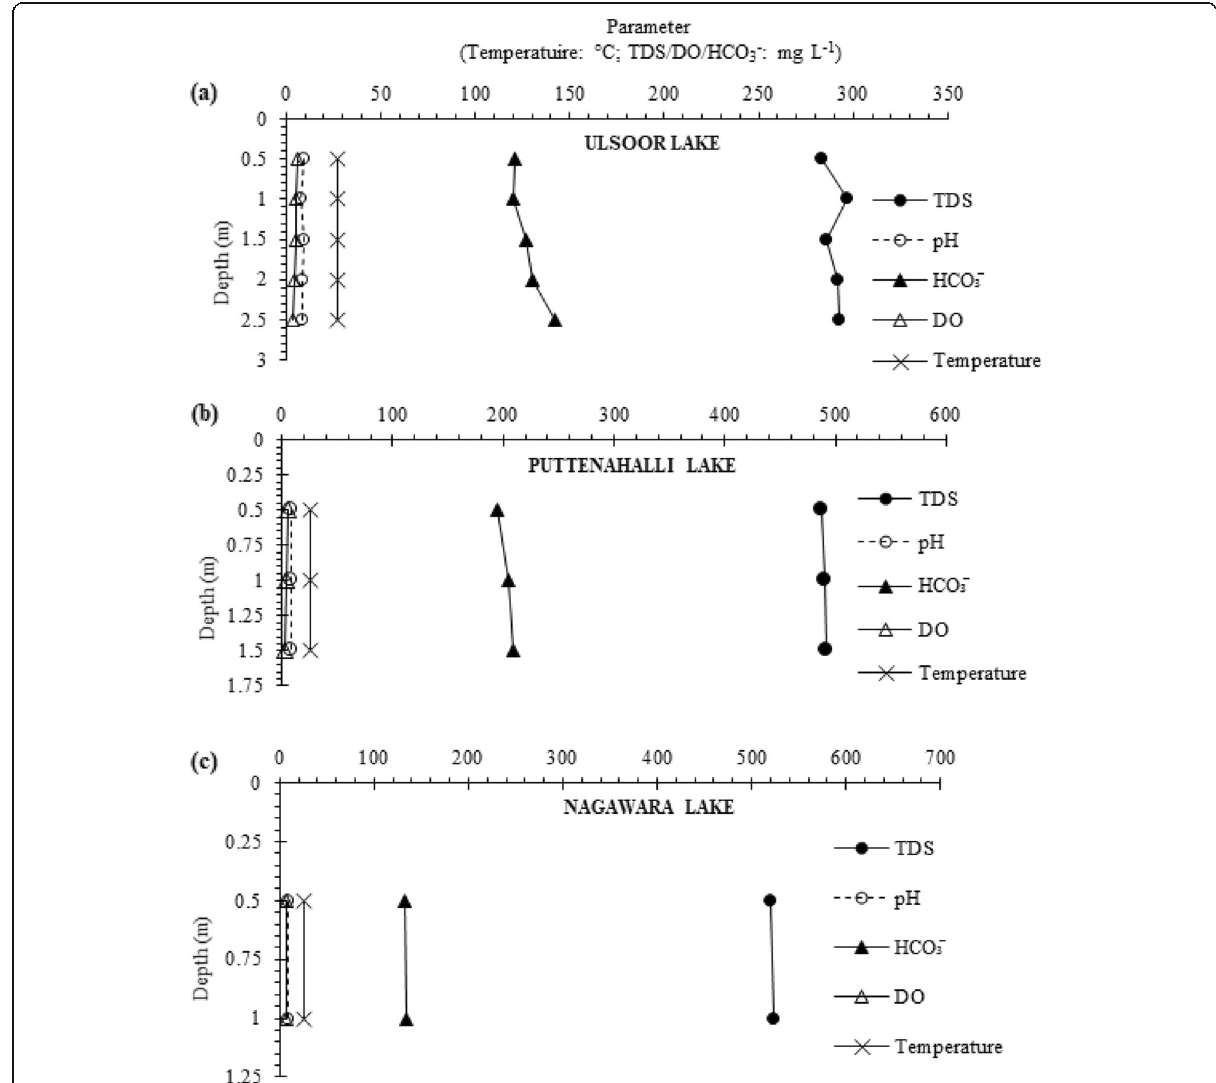
Fig. 2 Variation of physico-chemical parameters with depth of ( a ) Ulsoor lake ( b ) Puttenahalli lake and ( c ) Nagawara